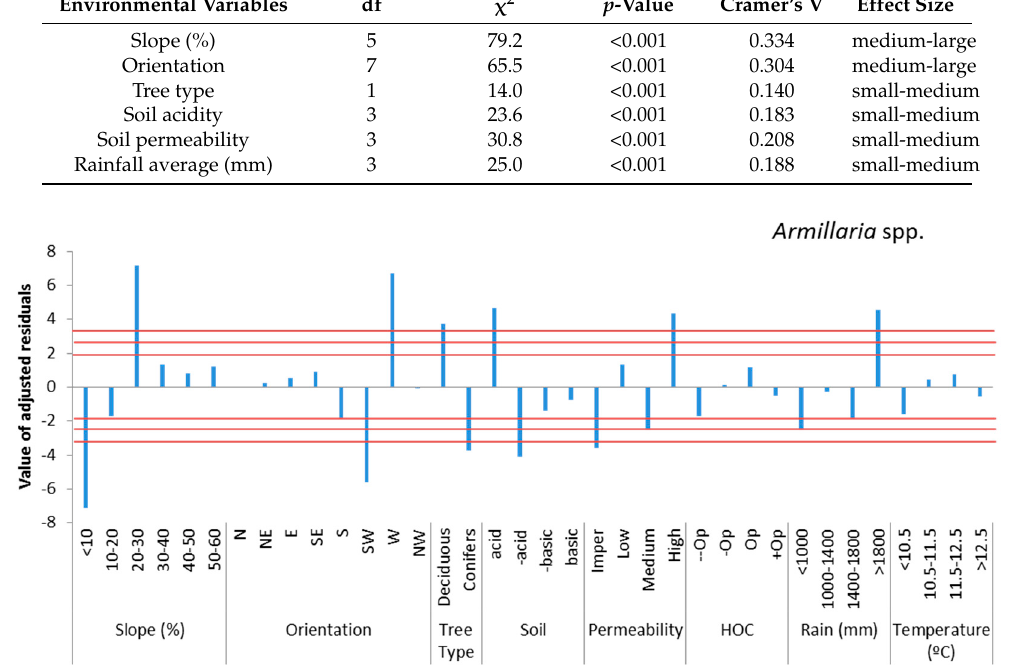
Figure 5. Values of the adjusted residuals (blue bars) for each category within a categorical variable for the presence of Armillaria spp. Red lines represent the value the adjust residuals must have to consider a category significant; if y = ± 1.96 then it is significant at p < 0.05, if y = ± 2.58 then it is significant at p < 0.01, and if y = ± 3.29 then it is significant at p < 0.001 (Field,